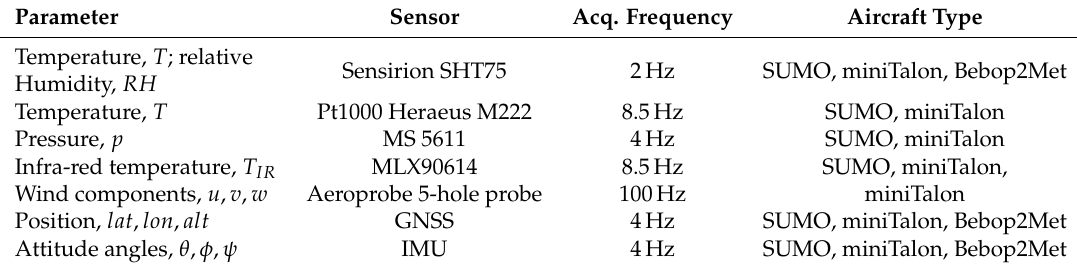
Table 3. Specifications for the paparazzi-based UAVs: Small Unmanned Meteorological Observer (SUMO), miniTalon, and